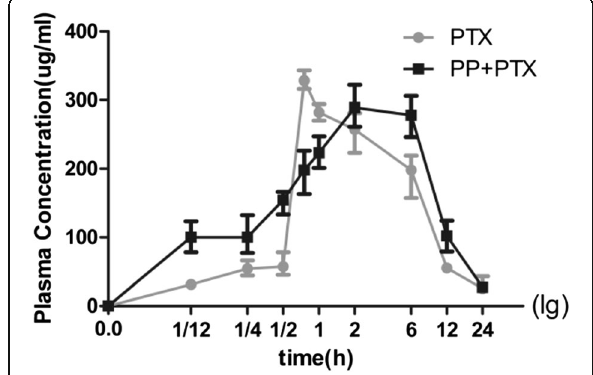
Fig. 9 The blood concentration – time curve. In mice after intravenously administered with PTX or PP+PTX. ( n